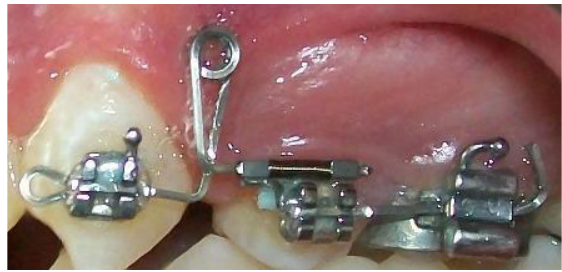
Figure 12: Remaloy cuspid retraction